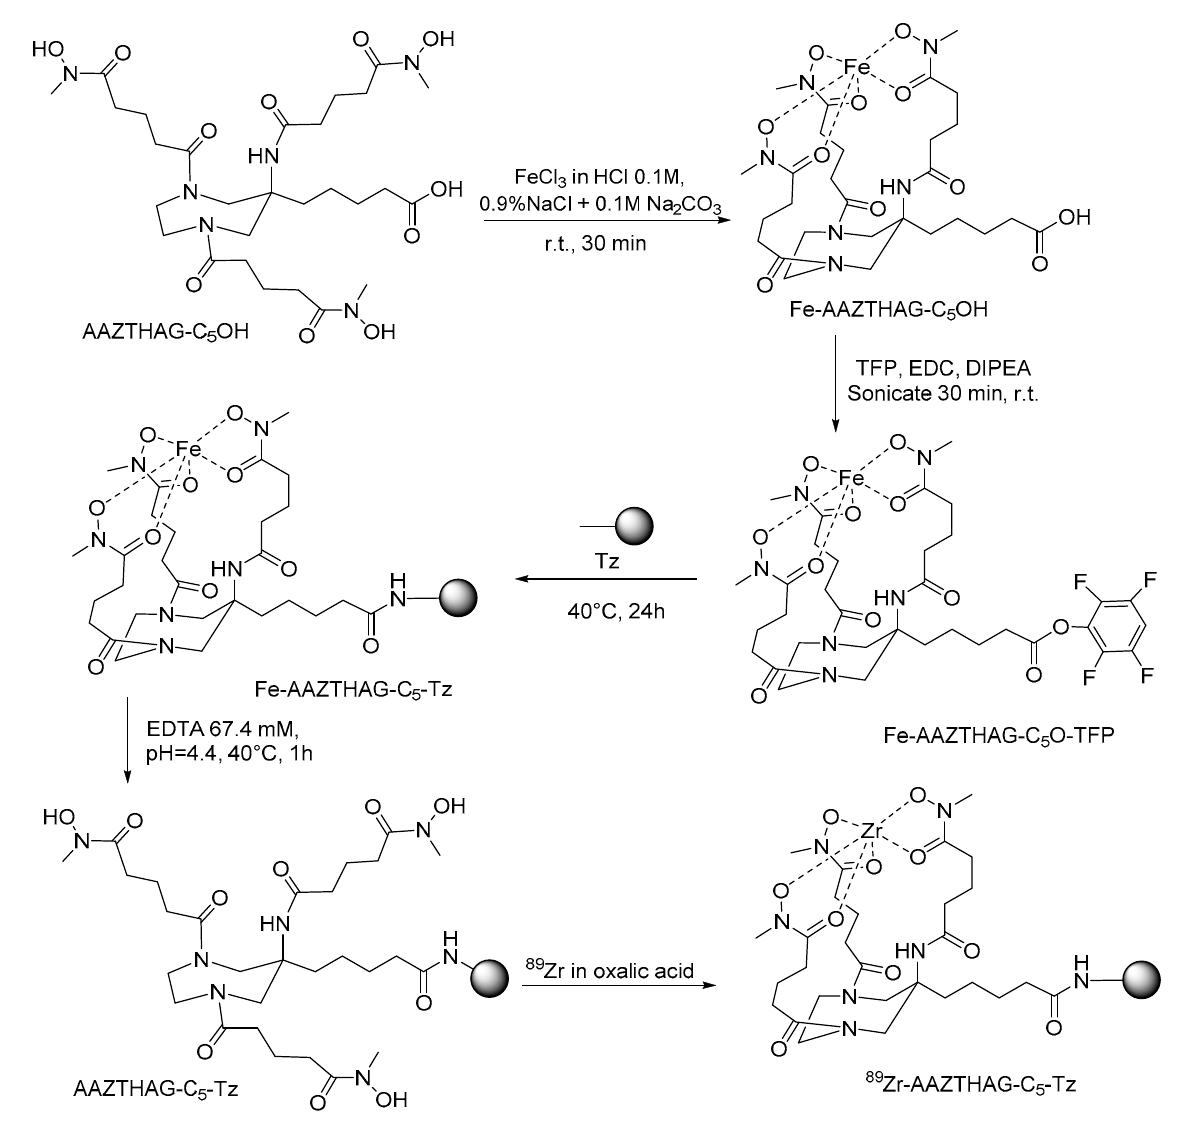
Figure 2. Synthesis scheme of 89 Zr-AAZTHAG-C 5 -Tz.